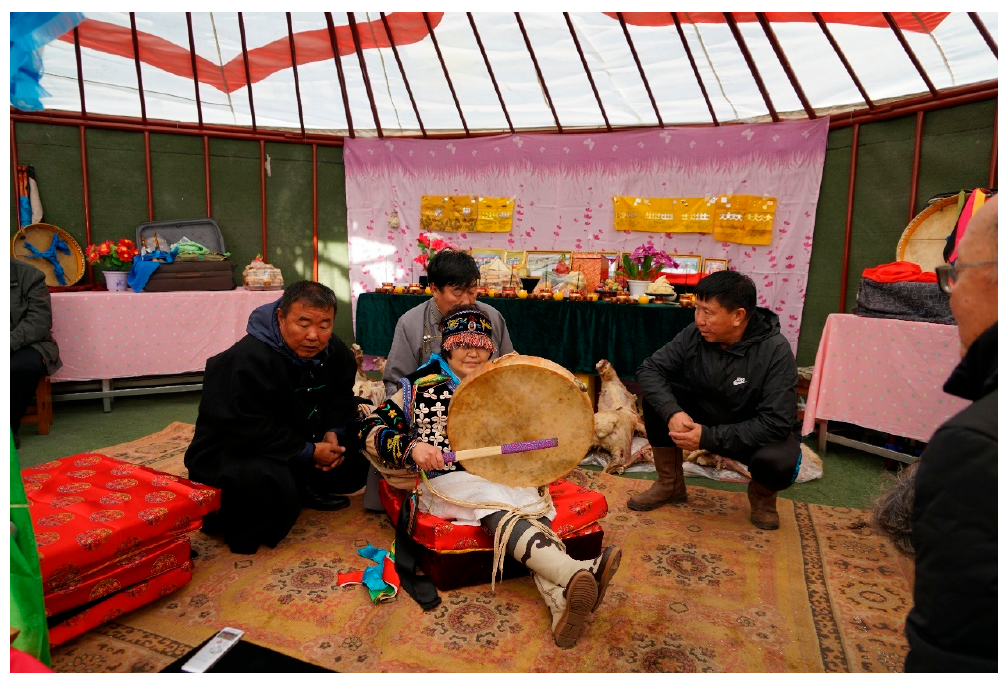
Figure A8. The new shaman ancestral spirit ʊ ŋ ɡ ʊ r is invoked (On 6 October 2017, Wo Liming’s initiation ritual as jad’ ə n ) Photo: Minna Sa, 2017.